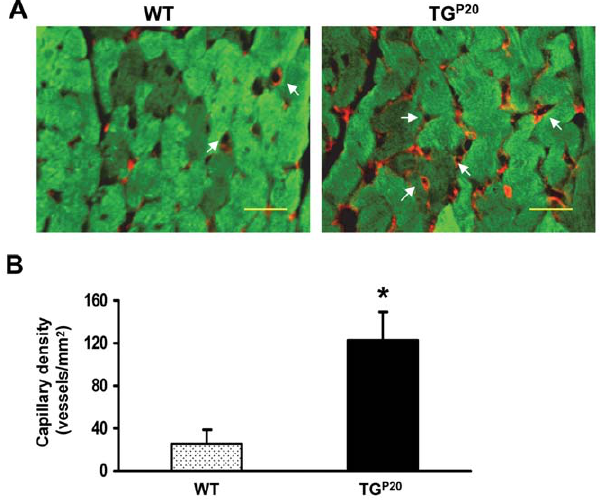
Figure 6. Cardiac-specific overexpression of Hsp20 promotes myocardial angiogenesis. (A) Blood vessels were stained for CD31 (capillary density) in heart sections of WT and Hsp20 TG mice, and (B) their quantitative analysis. For quantification of positively stained vessels, five sections of each heart (n=4 hearts per group) were analyzed by an investigator who was blinded with respect to samples. Blood vessels were detected at low magnification ( 6 200). Images are representative sections from four mice per group (green, a -Actin; red, CD31). Scale bar, 50 m m.